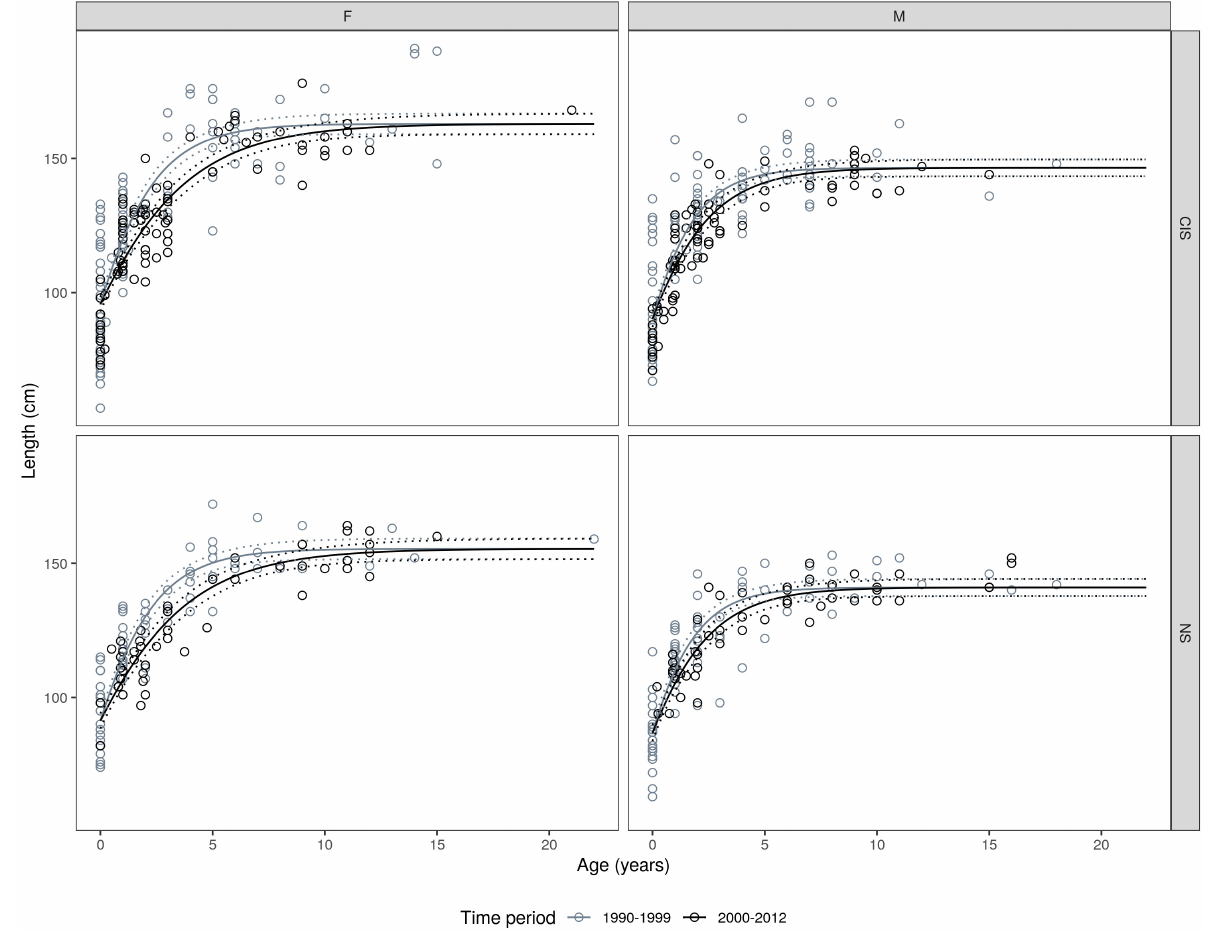
FIGURE 5 | Gompertz growth models fitted to the length-at-age data; fitted by sex, management unit, and time period (see Table 2 for n values and growth parameters). Stippled lines represent the 95% confidence intervals for the growth